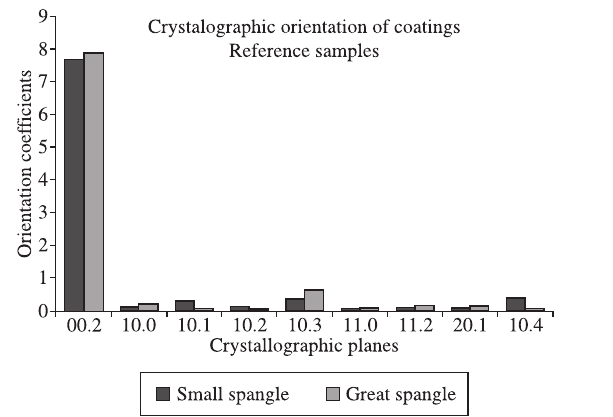
Figure 3. Orientation coefficients of the stretched galvanized samples.